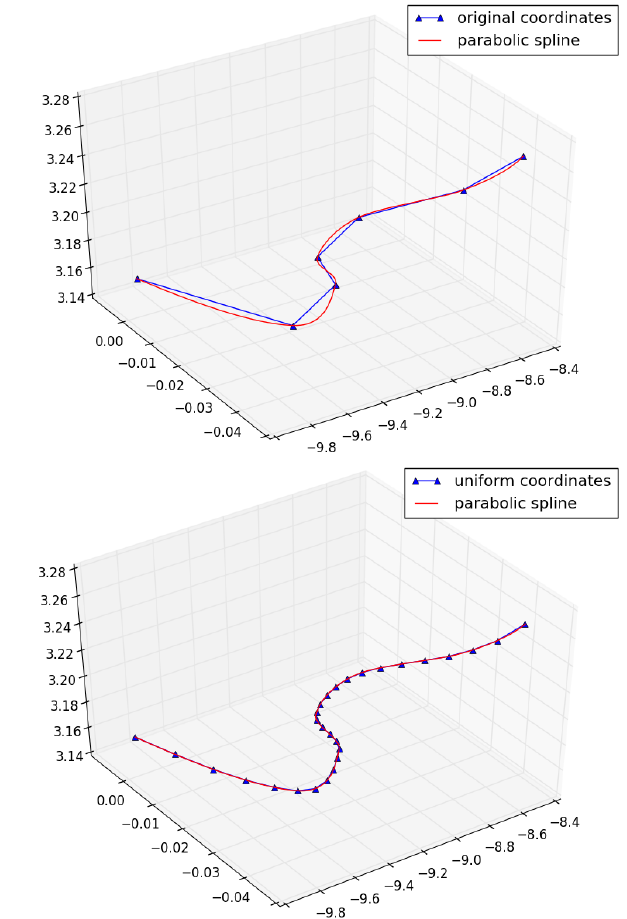
Figure 16. Parabolic spline interpolation. The curve representing lymphatic vessels is interpolated using given knots ( top ) and then divided into equal parts by evenly-spaced points ( bottom